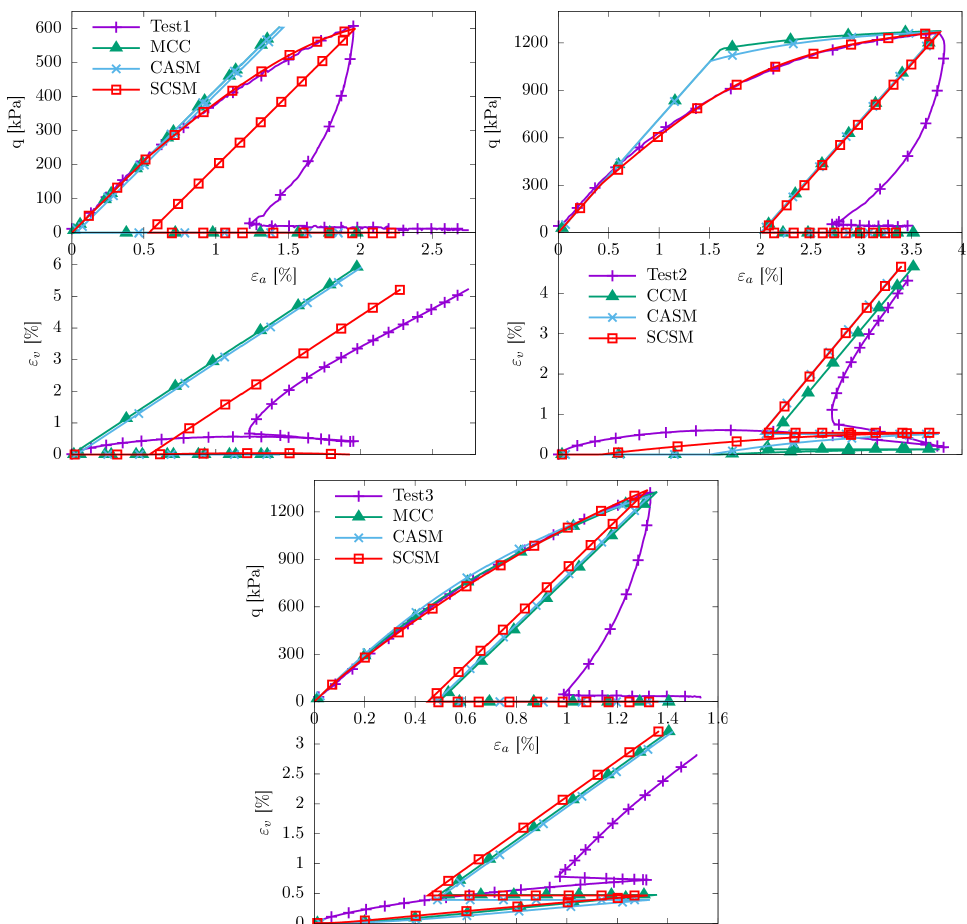
Figure 10: Simulation of specific stress controlled triaxial tests on a gray marl at different stress